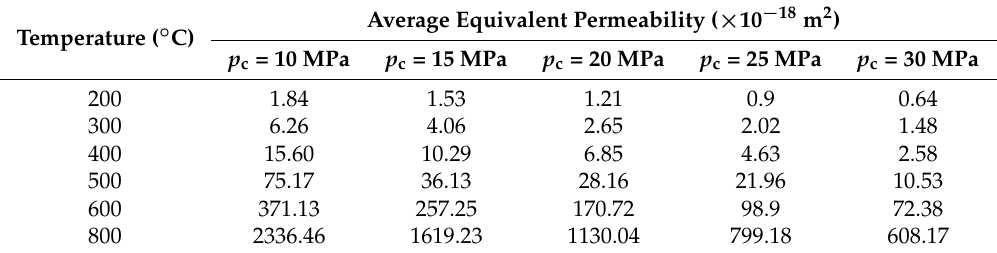
Table 2. Equivalent permeability after different temperature under different confining pressure. Temperature ( ◦